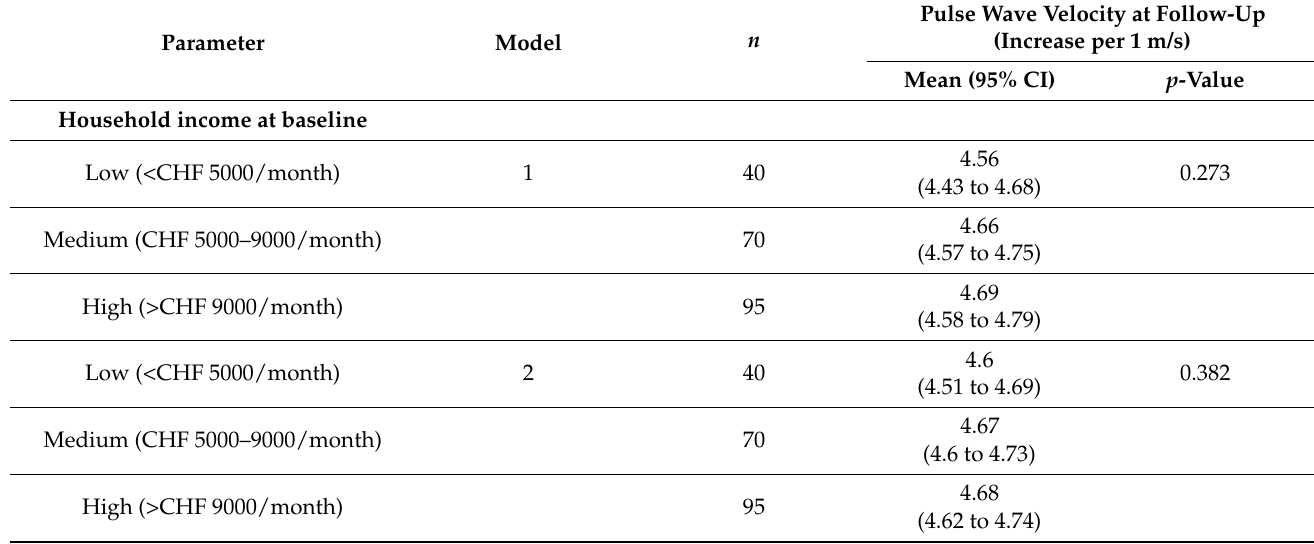
Table 2. Childhood pulse wave velocity in relation to categories of parental household income, education level, and migration